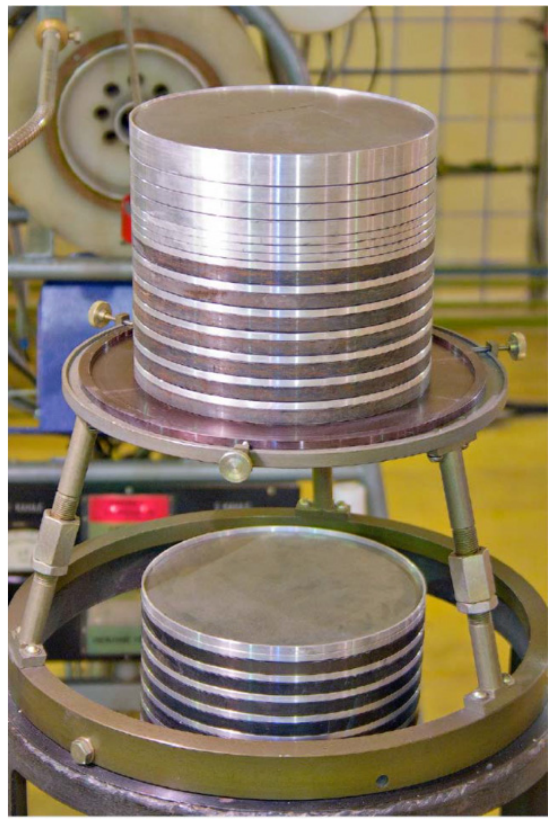
Figure 4. Molybdenum-diluted HEU cylinder approach to